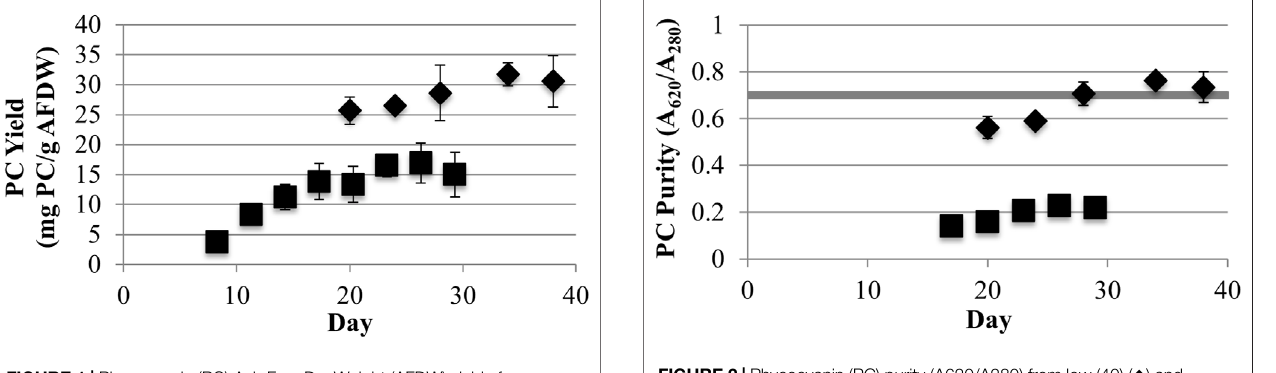
FIGURE 1 | Phycocyanin (PC) Ash Free Dry Weight (AFDW) yields from harvestedalgalbiomasswithlow(40)( ◆ )andhigh(220)( ■ )light( μ molphotons m − 2 s − 1 PAR) growth conditions (one standard deviation shown, n ≥ 3).